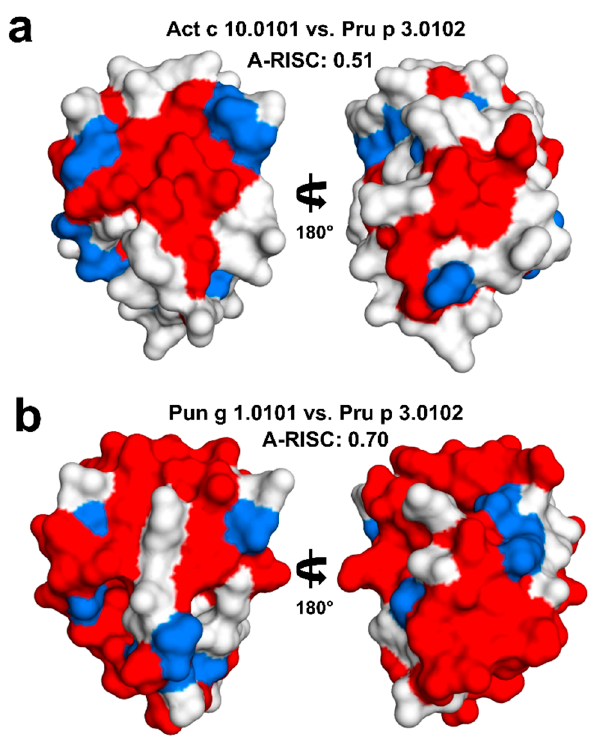
Figure 7. Surface residue conservation between Act c 10.0101 and Pru p 3.0102 ( a ), as well as be- tween Pun g 1.0101 and Pru p 3.0102 ( b ). Identical residues are marked in red, while similar resi- dues are marked in blue.